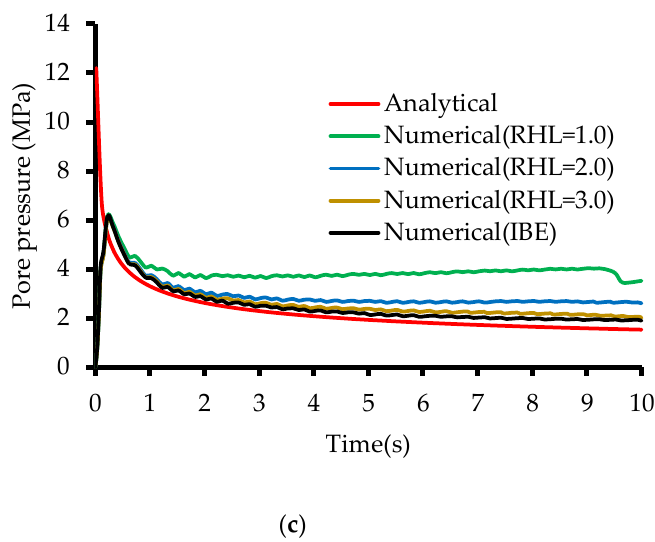
Figure 8. Comparison between numerical results with different boundary sizes and analytical results of large toughness. ( a ) Variation of fracture length with time; ( b ) fracture width at the injection point; ( c ) pore pressure at the injection point.